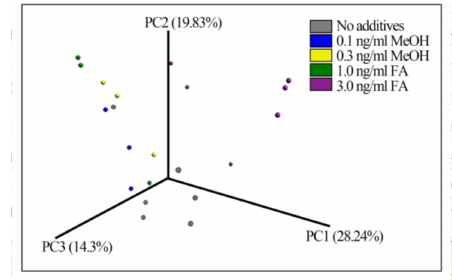
Figure 2. Fecal bacterial patterns of FA-treated mice differentiated by principal coordinate analysis (PCoA) on a Bray-Curtis distance matrix. The patterns show the bacterial taxa community after treatment with different doses of FA or MeOH for 24